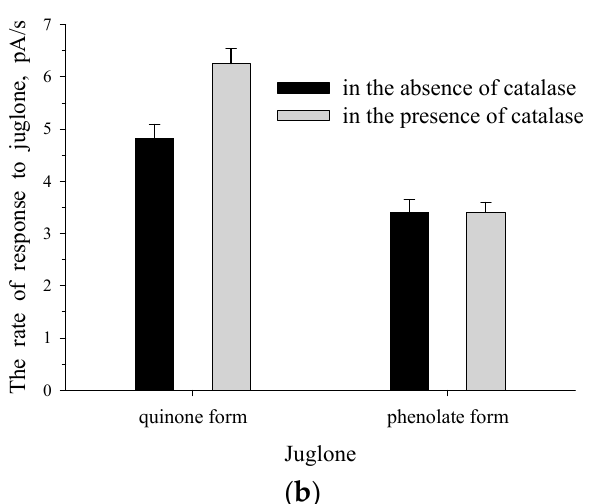
Figure 5. Response to juglone for intact cells of Rhodococcus sp. 3 ( a ) and Pseudomonas sp. 4(c4) ( b ) in the absence and presence of catalase.